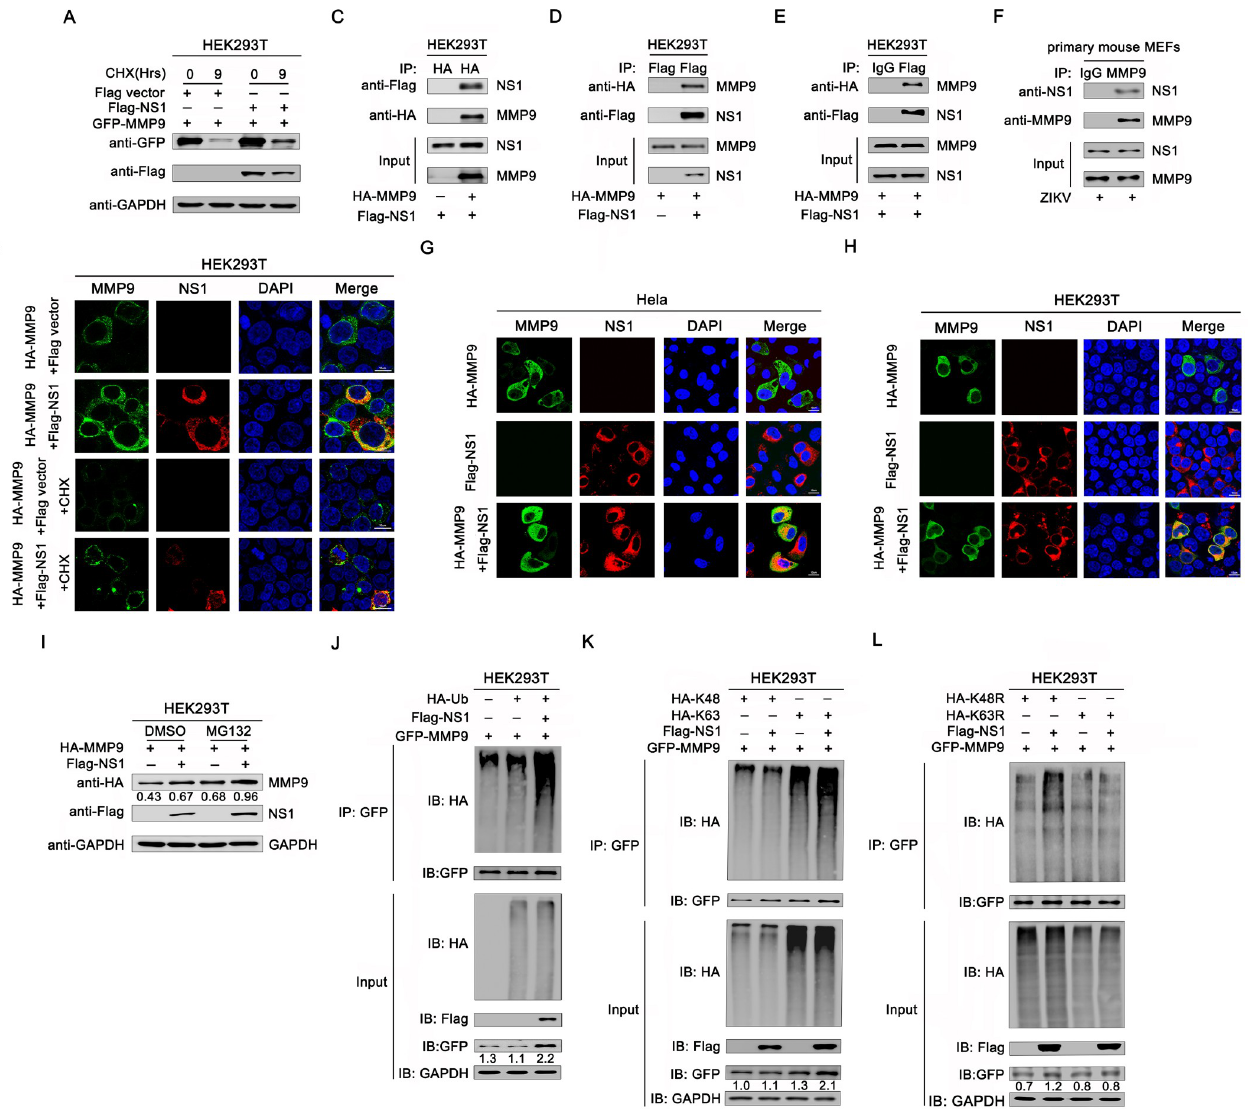
Fig 5. NS1 bound to MMP9 and facilitated K63-linked polyubiquitination of MMP9. ( A) HEK293T cells were cotransfected with empty vector, plasmid pcDNA3.1(+)-Flag-NS1 expressing Flag-tagged NS1 and plasmid pCAGGS-HA-MMP9 expressing HA-tagged MMP9. 48h later, cells were treated with 40 μ g/ mL CHX for 0, 9h, and then cells were lysed, and subjected to western blot with indicated antibodies. (B) HEK293T cells were cotransfected with empty vector/ Flag-NS1 and HA-MMP9 for 30h. Cells were treated with 40 μ g/mL CHX for 0, 9h, then immunostained with anti-Flag (red) and anti-HA (green) antibodies, and nuclei were stained with DAPI (blue) and analyzed by confocal microscopy. Scale bar, 10 μ m. (C-D) HEK293T cells were cotransfected with empty vector, Flag-NS1 and HA-MMP9, cells lysates were immunoprecipitated with anti-HA (C) or anti-Flag (D) antibodies. The immunoprecipitates and whole-cell lysates (WCLs) were analyzed by western blotting with anti-Flag and anti-HA antibodies. (E) HEK293T cells were cotransfected with plasmid Flag-NS1 and HA-MMP9. Cells were lysed, and cell lysates were immunoprecipitated with anti-Flag and anti-mouse immunoglobulin G (IgG) antibodies. The immunoprecipitates and whole-cell lysates (WCLs) were analyzed by western blotting with anti-Flag and anti-HA antibodies. ( F ) Primary MEFs were infected with ZIKV at an MOI of 1 for 30h, and cell lysates were immunoprecipitated with anti-MMP9 and anti-goat IgG antibodies. The immunoprecipitates and WCLs were analyzed by western blotting with anti-MMP9 and anti-NS1 antibodies. HeLa ( G ) and HEK293T cells ( H ) were cotransfected with Flag-NS1 and HA-MMP9 for 24h. Cells were immunostained with anti-Flag (red) and anti-HA (green) antibodies, and nuclei were stained with DAPI (blue) and analyzed by confocal microscopy. Scale bar, 10 μ m. (I) Immunoblot analysis of extracts of HEK293T cells transfected with plasmid for HA-MMP9 and Flag-NS1 and treated with dimethylsulfoxide (DMSO) or MG132. ( J ) HEK293T cells were cotransfected with pGFP-MMP9, pHA-Ub, and pFlag-NS1. Cell lysates were immunoprecipitated with anti-GFP antibodies and immunoblotted with anti-HA antibodies. ( K) HEK293T cells were cotransfected with pGFP-MMP9, pHA-K63, and pHA-K48, together with pFlag-NS1. Cell lysates were immunoprecipitated with anti-GFP and immunoblotted with anti-HA antibodies. ( L) HEK293T cells were cotransfected with pGFP-MMP9 and pHA-K63R or pHA-K48R, together with pFlag-NS1. Cell lysates were immunoprecipitated with anti-GFP antibodies and immunoblotted with anti-HA antibodies.